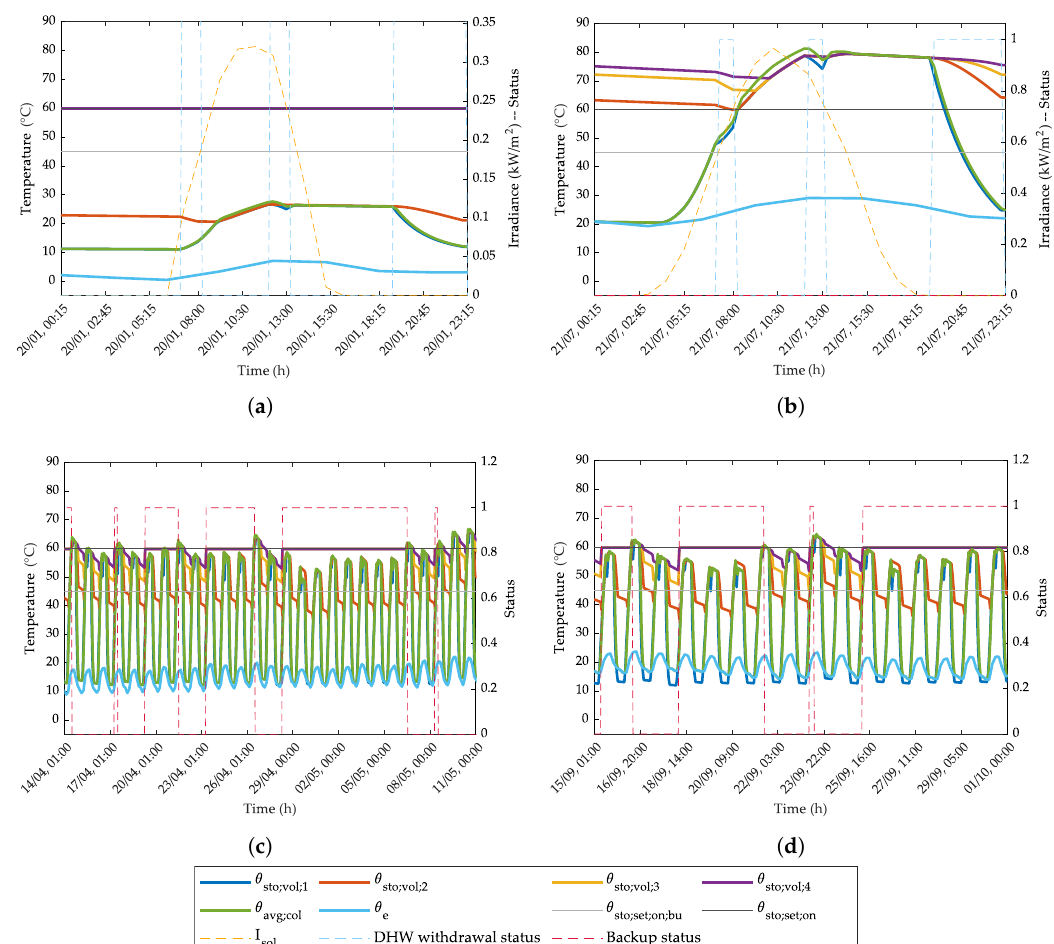
Figure 7. Results from standard simulation: ( a ) a winter day; ( b ) a summer day; ( c ) spring mid-season; ( d ) fall mid-season. Solar pump running when Q sol;loop;out ≥ 3 · P sol;pmp · 10 − 3 · t ci .